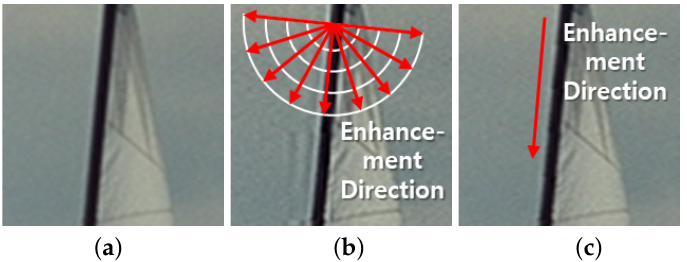
Figure 4. Reducing ringing artifact by direction-adaptive method. ( a ) Original edge image. ( b ) Image enhanced by the proposed method without direction-adaptive method. ( c ) Image enhanced using the proposed method with direction-adaptive method.